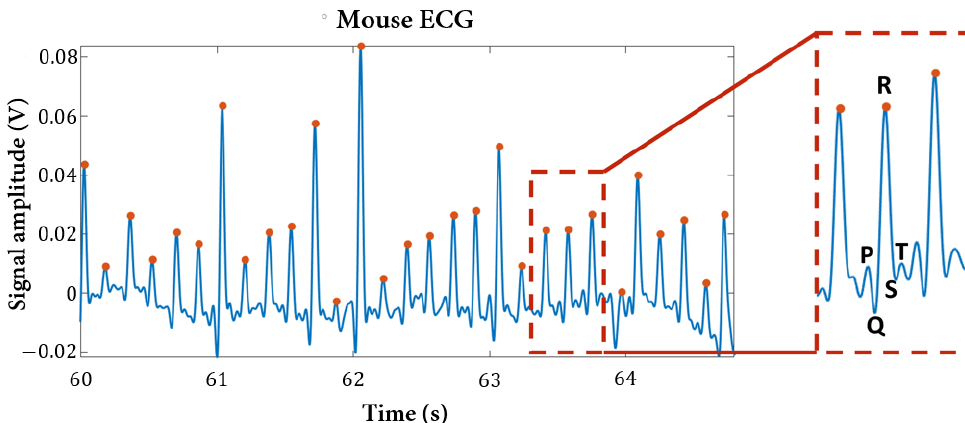
Figure 12. ECG signal from the non-invasive system with dry electrodes. The observed signal was filtered with a bandpass filter between 1 and 20 Hz, to be possible to capture all the ECG waves (P, QRS complex and T) highlighted in the